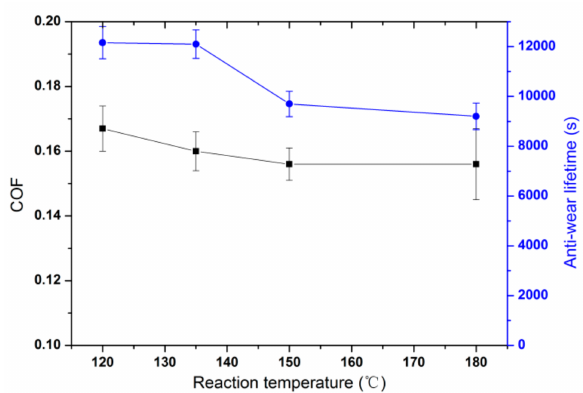
Figure 6. The influence of reaction temperature for hydrothermal method on COF and anti-wear lifetime of HRGO-APS coating on titanium alloy substrates.